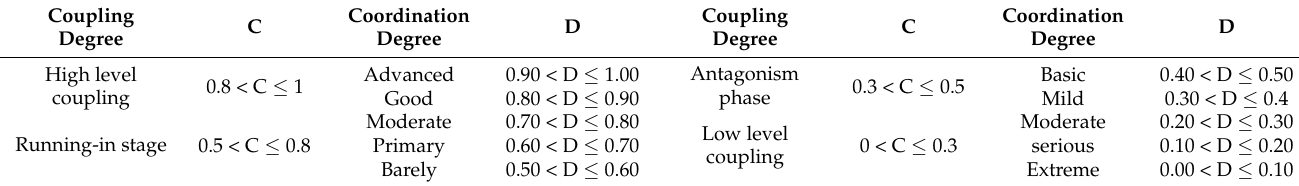
Table 1. The grade standard of coupling degree and coordination